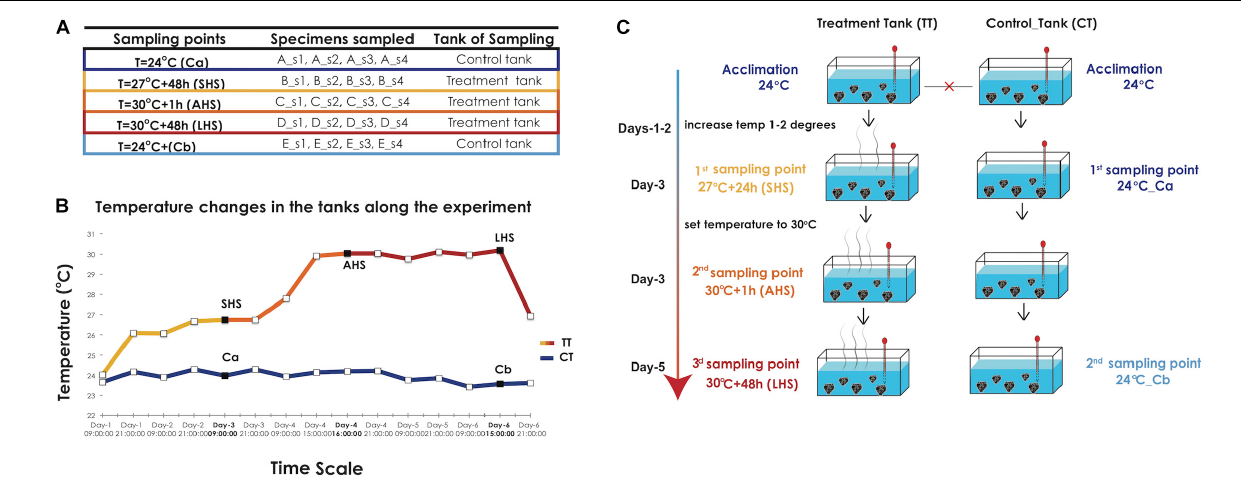
FIGURE 1 | Experimental design. (A) The number and labeling of biological replicates and clones collected in each sampling point from the treatment and the control tank. (B) Graph indicating the temperature conditions in the TT and CT along the time of the experiment, as recorded by HOBO loggers. The three sampling points in the TT curve and the two sampling points in the CT, respectively, are indicated with black squares. SHS, Short-term Heat Shock; AHS, Acute Heat Shock; LHS, Long-term Heat Stress, CT, Control Tank; TT, Treatment tank. (C) The diagram depicts the different stages of temperature increases at the treatment tank (TT) and the sampling points at the control and treatment tank (CT, TT) along the duration of the